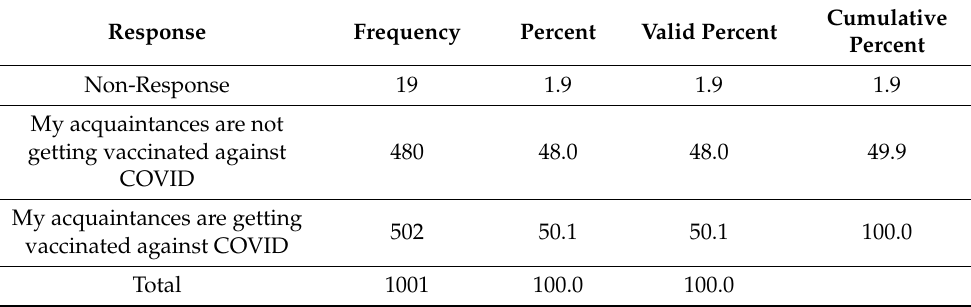
Table 3. The respondents’ perception towards COVID-19 vaccination of their acquaintances.